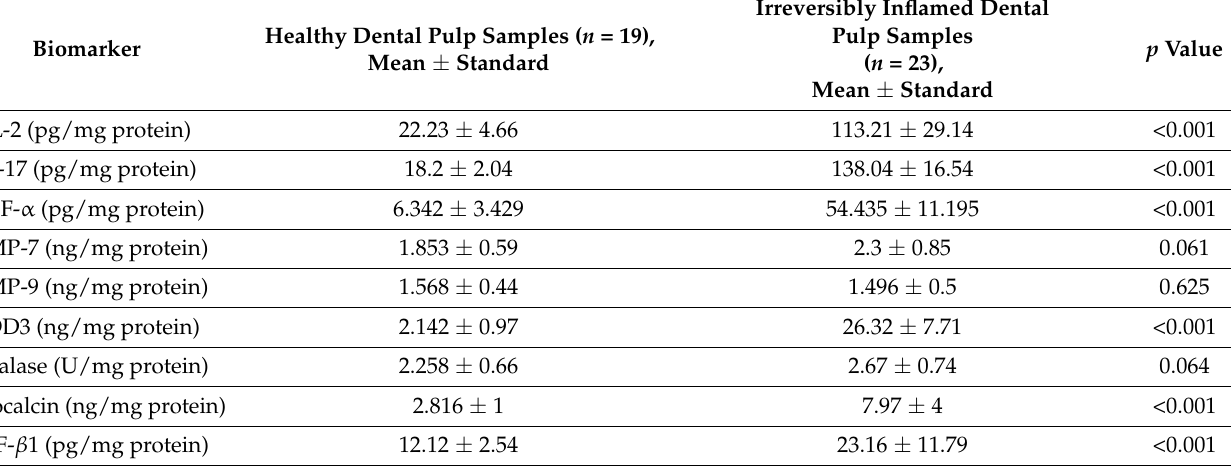
Table 1. Mean levels of IL-2, IL-17, TNF- α , MMP-7, MMP-9, SOD3, catalase, osteocalcin, and TGF- β 1 in healthy and irreversibly inflamed dental pulp